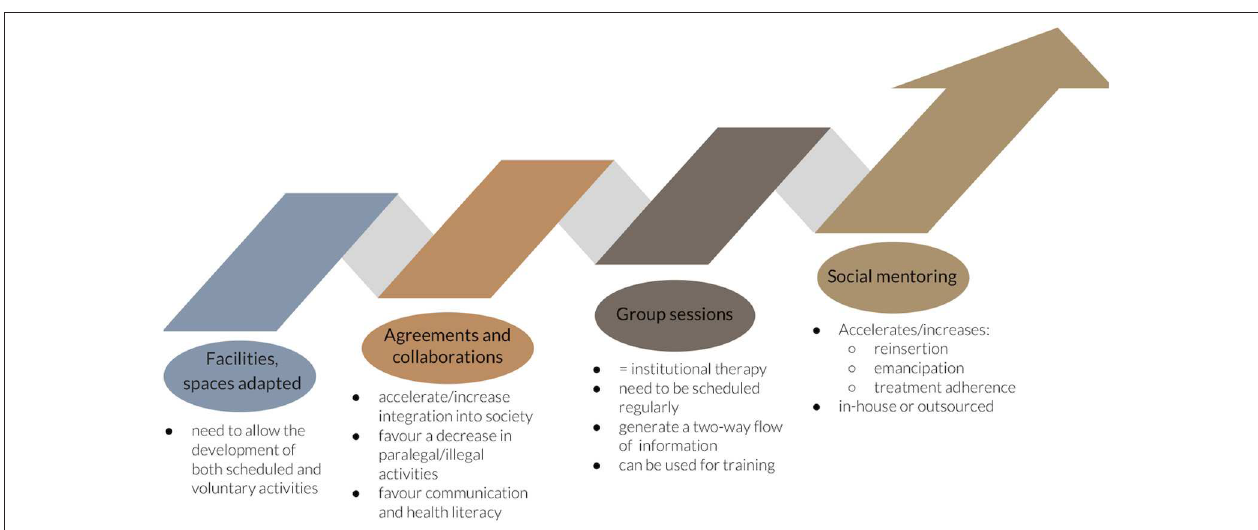
FIGURE 1 | Interventions proposed at the level of the diagnostic and/or treatment center.